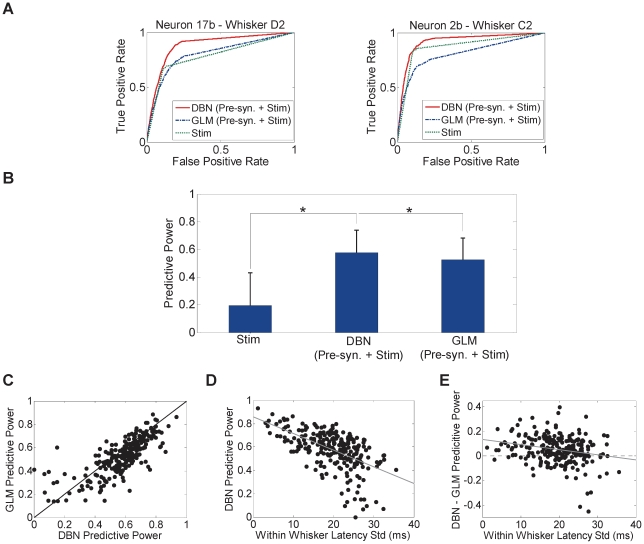
Predicting single neuron firing.(A) ROC curves of sample neuron 2b in response to whisker C2 deflection (left) and neuron 17b in response to whisker D2 deflection (right) in rat R2. Predicted spike trains were obtained using the pre-synaptic cells' history inferred by DBN and stimulus onset time, pre-synaptic cells' history inferred by the GLM and stimulus onset time, and the stimulus onset time only. Each curve was computed from tenfold cross-validation datasets. (B) Predictive power comparison across all rats for multiple models (mean ± SD). * P<0.001, two-sample t-test. (C) GLM predictive power versus that obtained using DBN and stimulus onset time. Black diagonal line represents equal prediction (n = ). (D) Predictive power obtained using DBN and stimulus as a function of the variability in mean first-spike latency. (E) Difference between predictive power for each neuron obtained using DBN and stimulus and that obtained using GLM as a function of the variability in mean first-spike latency. Each dot corresponds to one neuron for a given whisker (n = 240). Gray lines in (D) and (E) indicate regression lines.